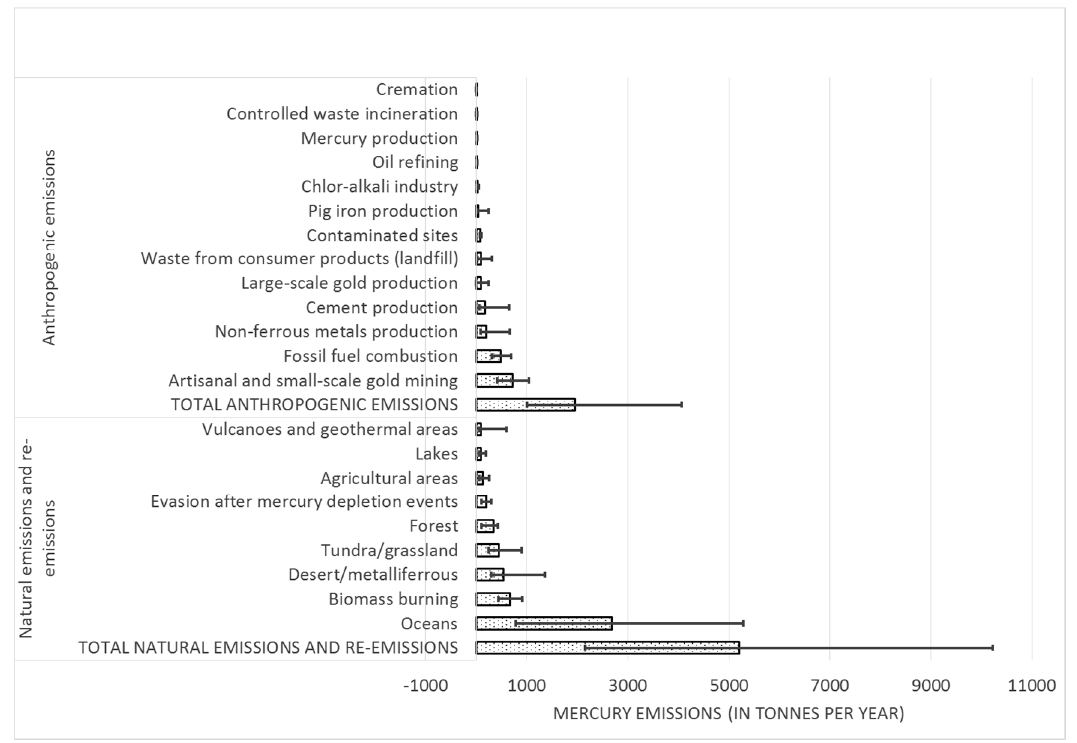
Figure 2. Global sources of mercury emissions with uncertainties. Based on [13,17,33].